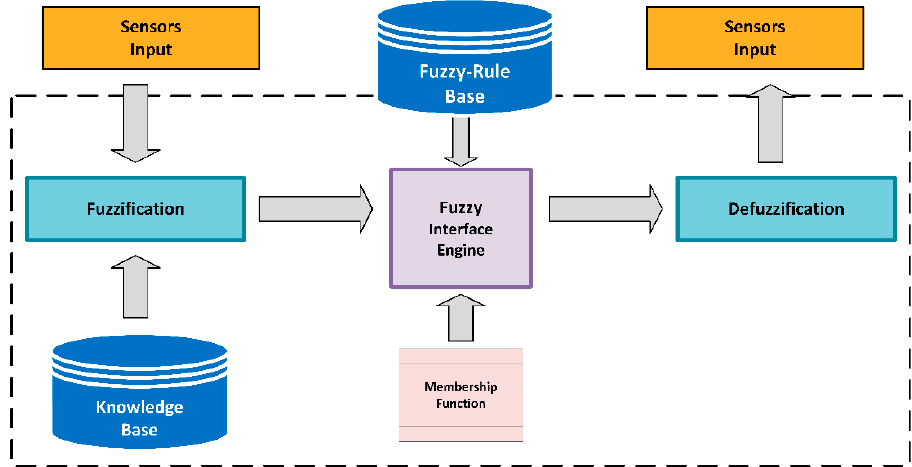
Figure 5. Fuzzy logic System for crop recommendation.